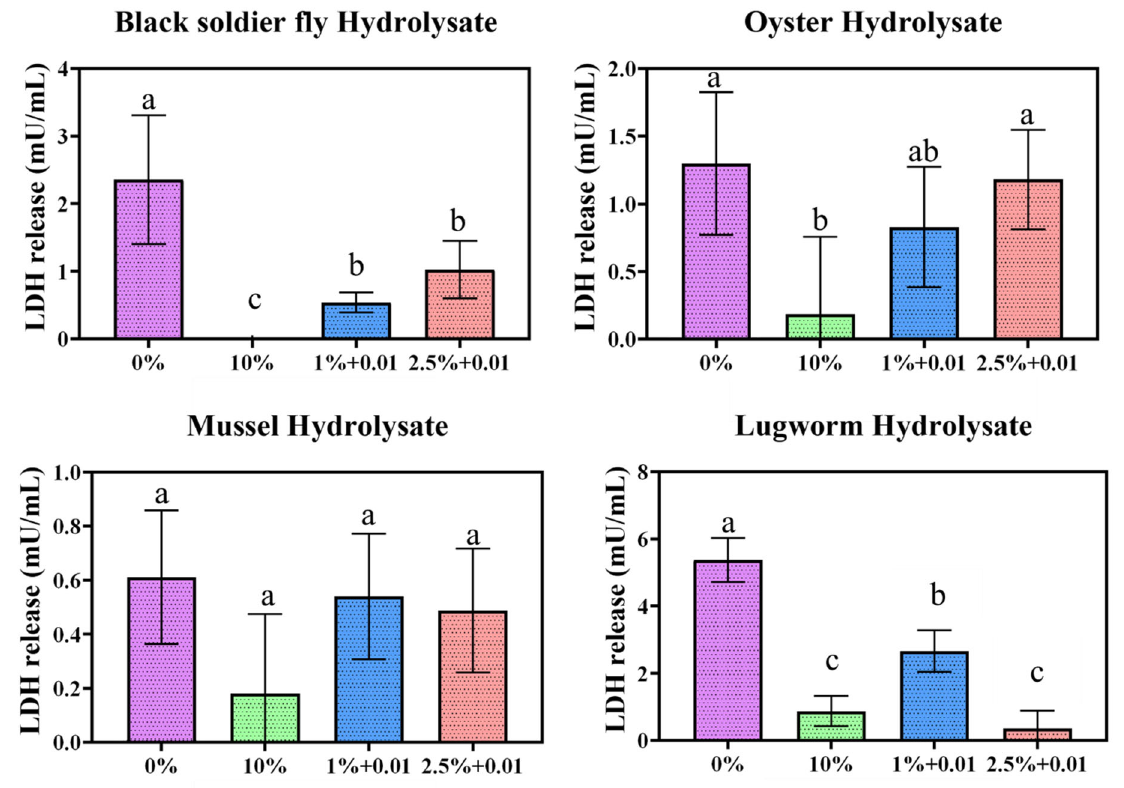
Figure 8. Lactate dehydrogenase assay conducted for protein hydrolysate conditions at 2.5 and 1% serum concentrations. a represents significantly different ( p < 0.05) from 10% control, b represents significantly different ( p < 0.05) from 0%